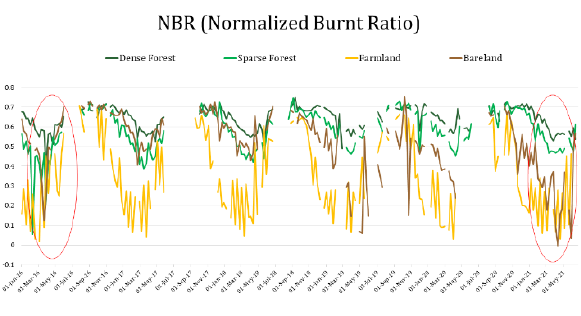
Fig. 6: Mean NBR for 30 random points taken in each land cover class of Mizoram area from year 2016-2021.